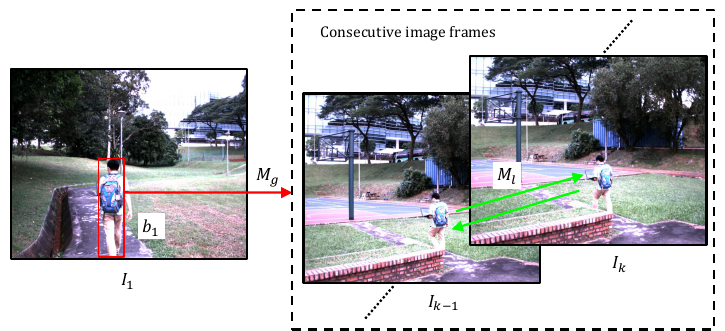
Figure 1. Illustration of the global matching and local tracking (GMLT) module. The bounding box b 1 is shown with the red rectangle. The FAST features detected in the b 1 compose the global object model M g , which is employed to globally find the feature correspondences on onboard captured consecutive image frames with the improved BRIEF descriptor. The green arrow is the Lucas–Kanade optical flow algorithm-based tracking between the ( k -1) -th frame and the k -th frame. M l is the local object model, which is updated frame-by-frame.